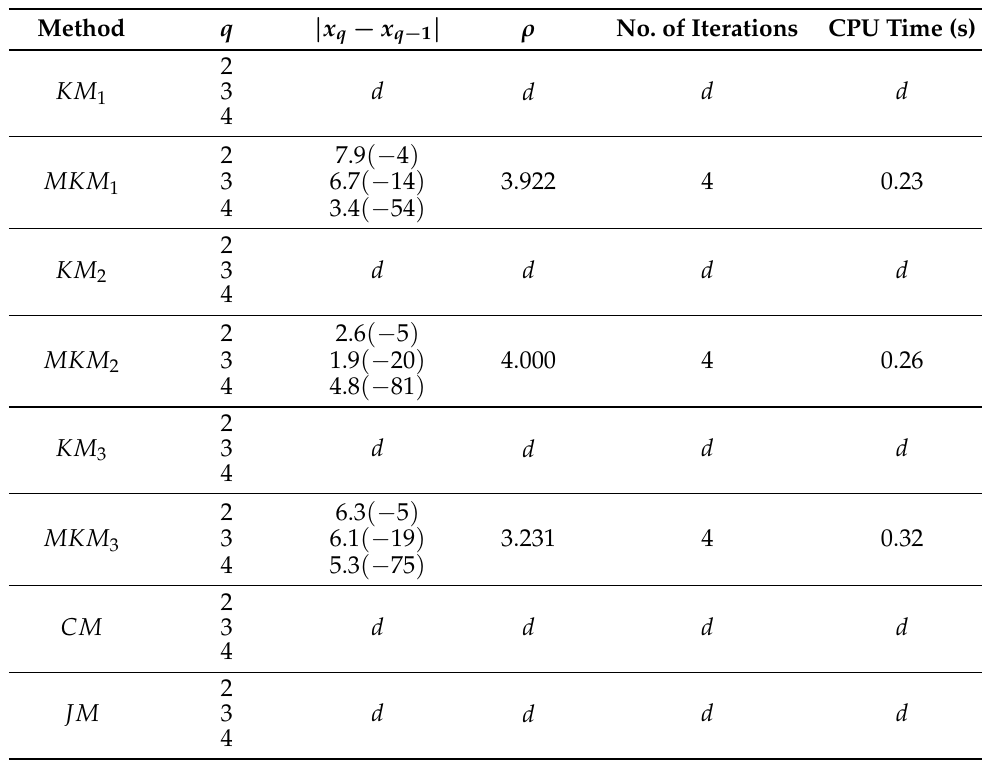
Table 6. Example 4(c) at initial point x 0 = 4.5.